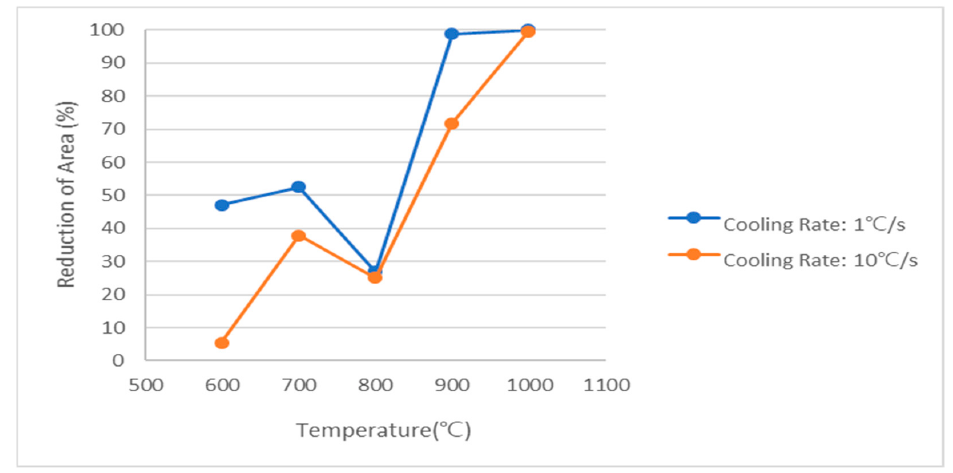
Figure 10. Comparison of RA behavior according to the cooling rate of Nb-added steel. Various alloying elements are added to steel to achieve high strength, weight reduc- tion, and thickening. When the cooling rate of a cast steel having the same composition is the steel structure, and the ductility of the steel decreases in the low temperature region